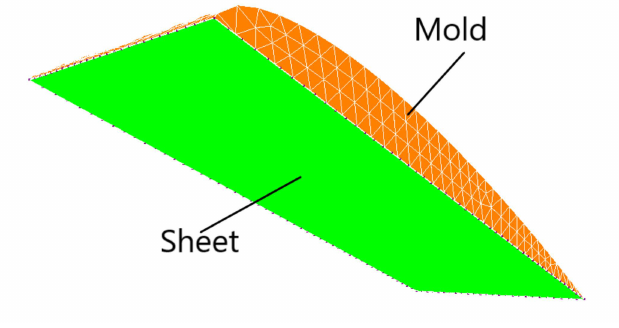
Figure 7. Geometries of the mold and the HDPE-PMSQ sheet.